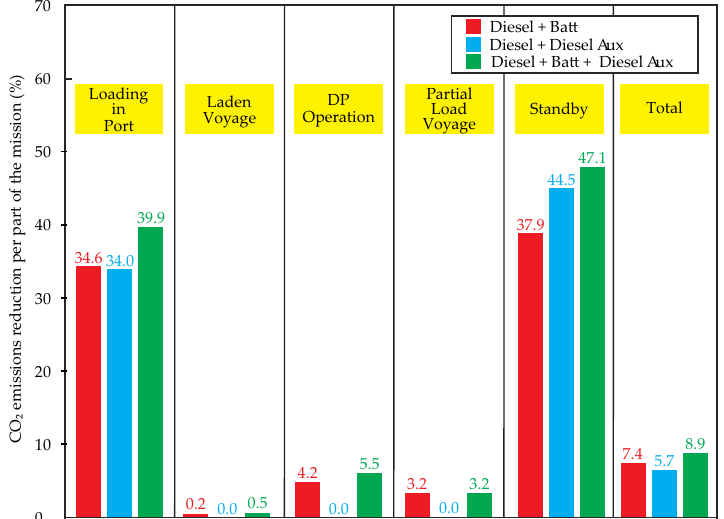
Figure 15. Reduction of CO 2 emissions in each mission part of the ship routine. Loading in port and standby, which are the operations with the lowest power requirements, also present the highest reduction when the batteries and/or auxiliary generators are used. When only diesel generators are used (base case), these mission parts are run at low efficiency points in the specific fuel oil consumption curve of the 1850 kW diesel generators. The impact of the reduction in these mission on the total reduction remains small because the sum of the CO 2 emitted during loading in port and standby represents less than 15% of the total CO 2 emitted during the mission. The low reduction during laden voyage and partial load voyage pulls the total emissions results down since these operations represents more than 56% of the emissions in all of the cases